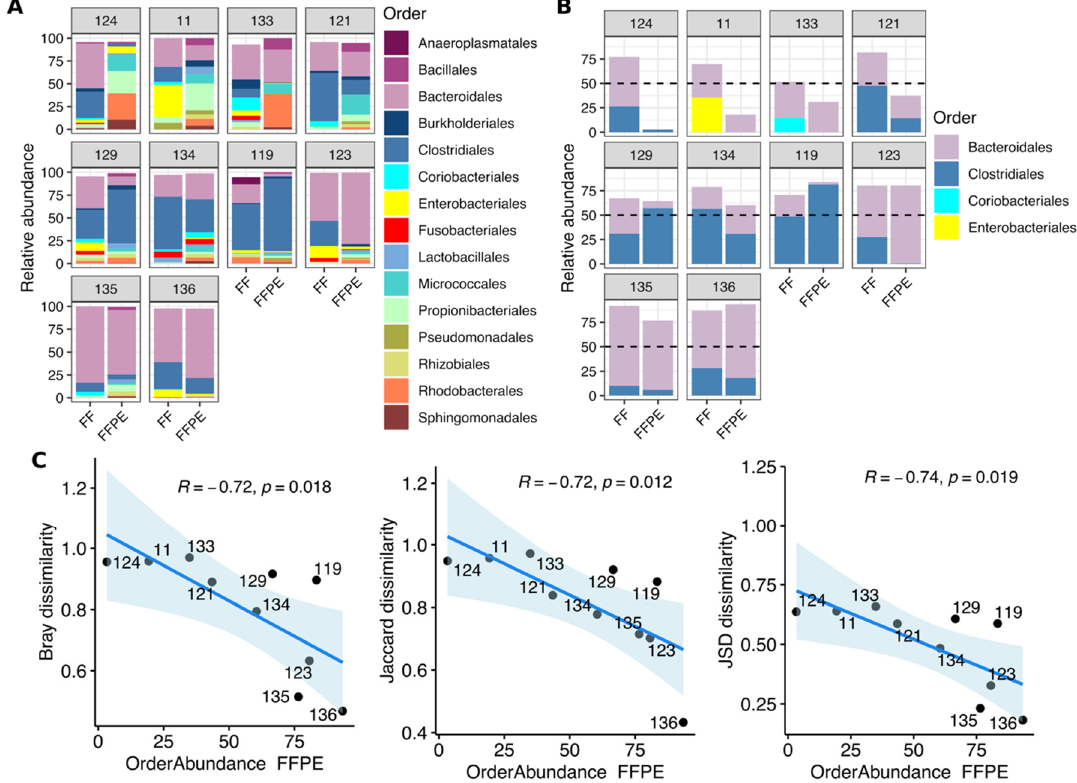
Figure 5. Correlation between community similarity and bacterial dominance in FF and FFPE sample pairs. ( A ) Comparison of bacterial composition (top 15 most abundant orders) between paired FF and FFPE samples. ( B ) Representation of two most abundant bacterial orders in FF tissues characterized in their matched FFPE samples. ( C ) Scatter plots showing spearman’s correlation between Bray–Curtis, Jaccard and Jensen–Shannon dissimilarity metrics and bacterial dominance in FFPE samples. Dissimilarity matrices are based on all microbial communities present in paired FF and FFPE CRC tissue microbiome ( y -axis). In x -axes, bacterial dominance is expressed as the sum of the two most abundant orders in FF measured in their matched FFPE samples. Spearman’s correlation coefficient and BH-adjusted p -values are indicated on the top of each panel. ( A – C ) Sample reads were randomly rarefied to the minimum sample depth (5808 sequences). ( A , B ) Sample pairs are ordered based on increasing similarity. Abbreviations: FF; fresh frozen and FFPE; formalin-fixed